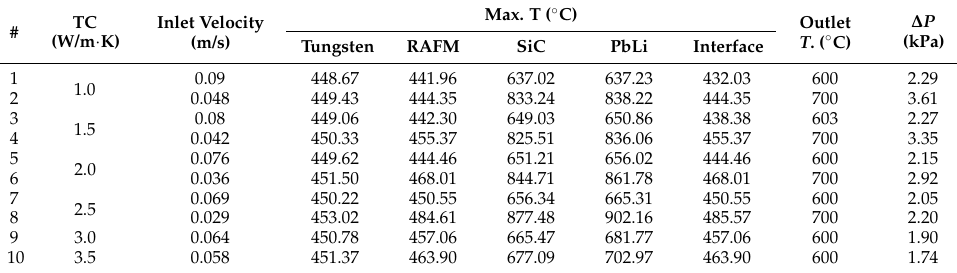
Table 5. Results summary for the selective